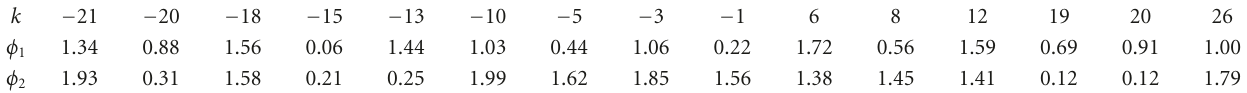
Table 1: Schroeder’s phases ( φ 1 ) and PSPR improving phase values obtained from the modified GA ( φ 2 ) for P =